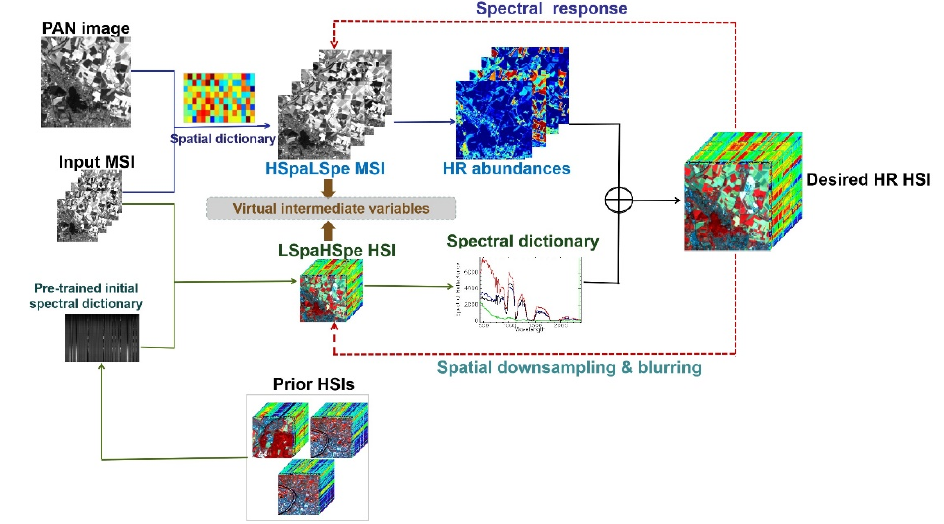
Figure 1. The framework of the proposed method.